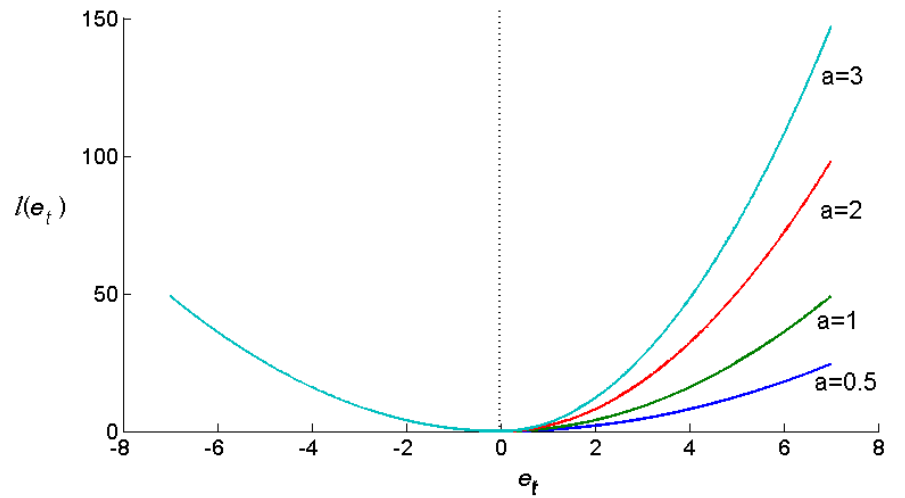
Figure 2. l in Type I Asymmetric Loss Function with Different Parameters ( p = 2). aI